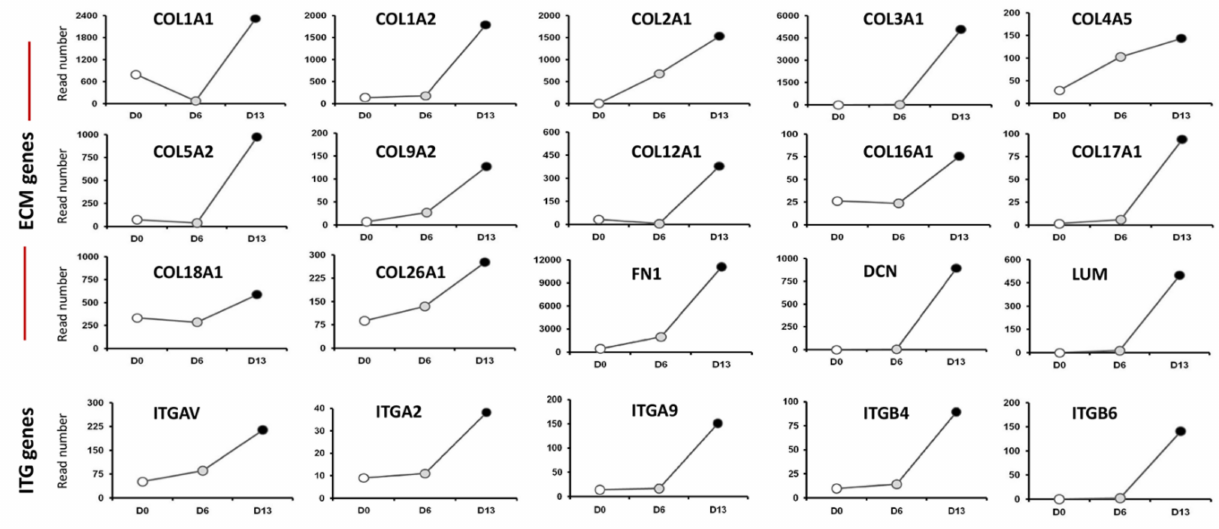
Figure 5. Representative HTS expression profiles for extracellular martix (ECM) and integrins (ITG) gene family members that are progressively enriched in day 6 and day 13 differentiated cell cultures. The HTS revealed an upregulation of a panel of known ( COL1A1 , COL1A2 , COL2A1 , COL9A2 ) and unknown ( COL3A1 , COL5A2 , COL12A1 , etc.) ECM genes. The HTS analysis also showed upregulation of a subset of known ( ITGAV , ITGB4 ) and unknown ( ITGA2 , ITGA9 , etc.) ITG genes in the mammalian embryonic inner